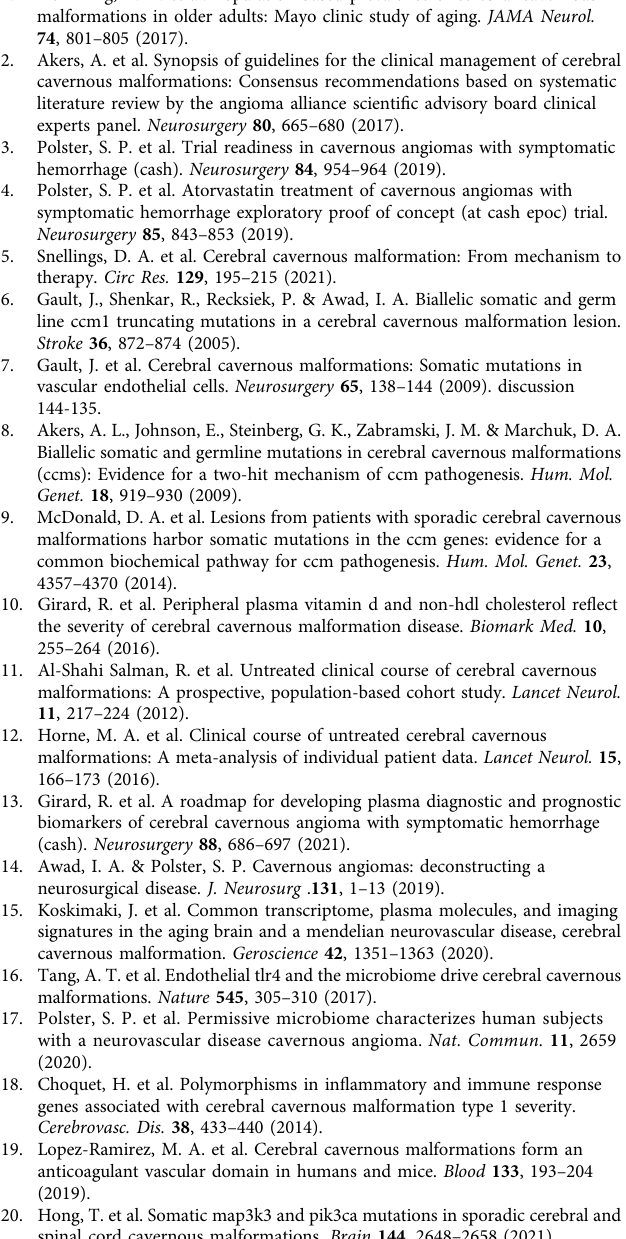
Fig. 2. Supplementary Data 4 contains the source data for Figs. 3, 4. Supplementary Data 7 contains the source data for Fig. 5. Any additional records are available from the corresponding authors upon reasonable